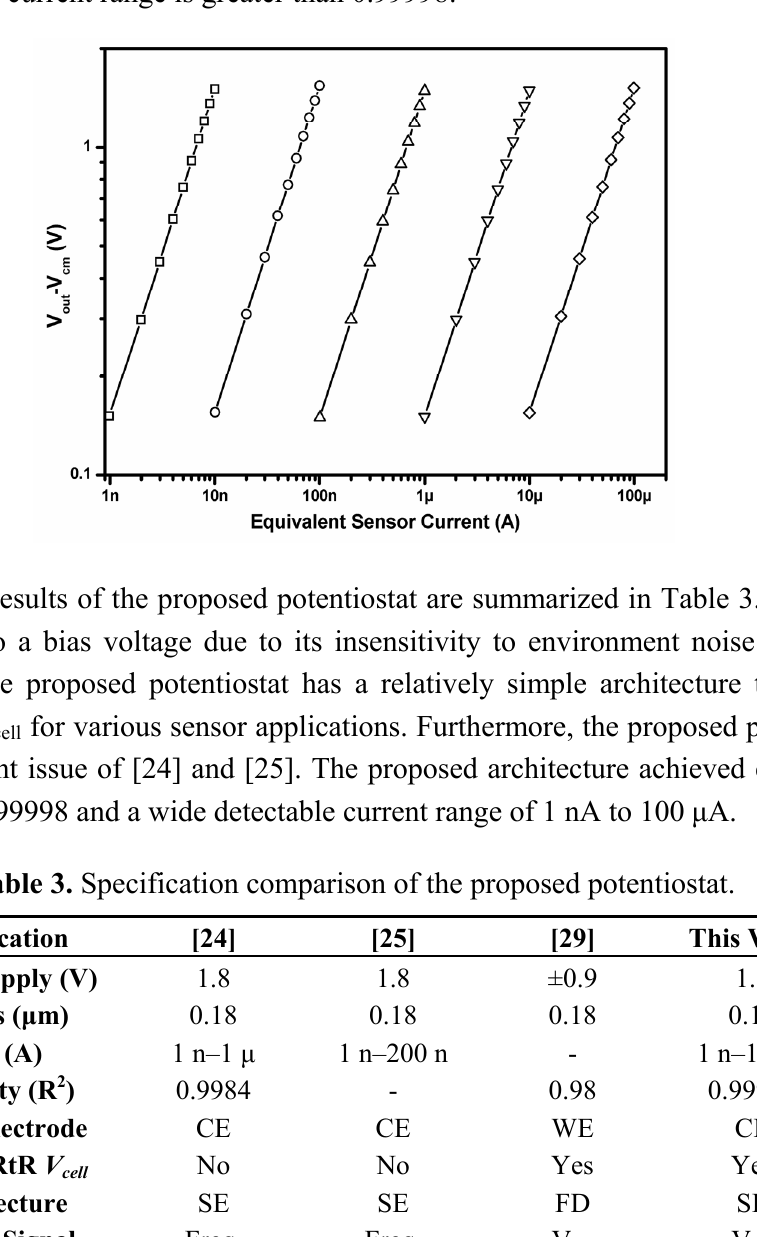
− V of the proposed potentiostat. The out cm